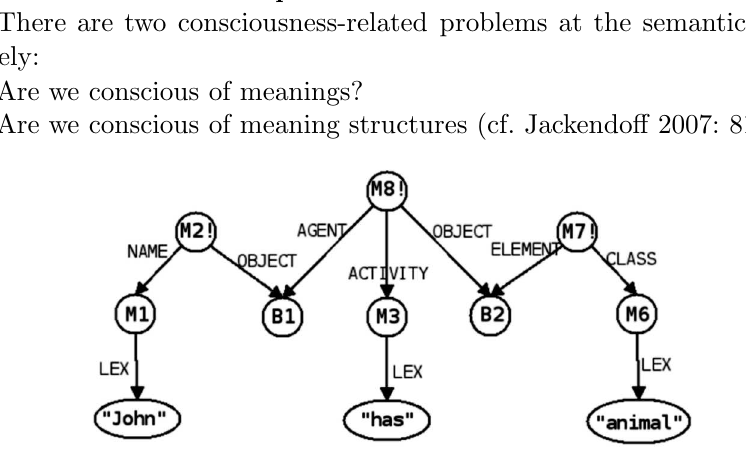
Figure 3. A semantic network encoding proposition “John has (an)